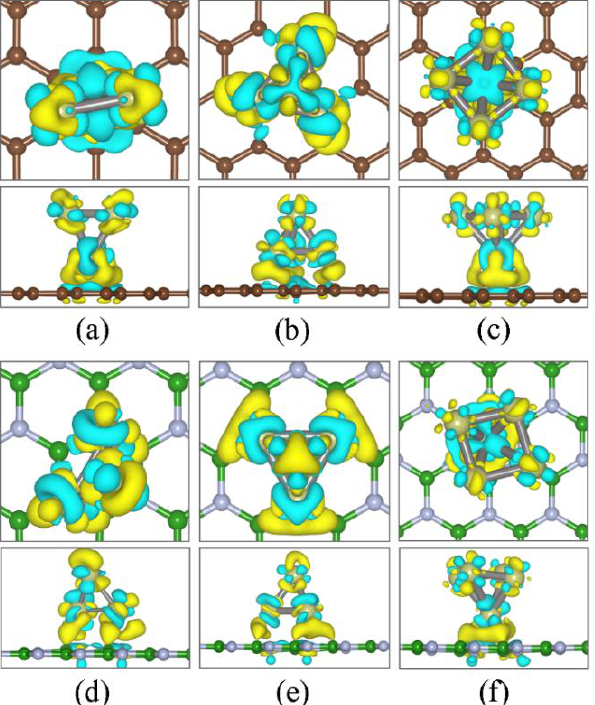
Figure 6. CDD of the most stable structure of Ir 3 to Ir 5 adsorbed on graphene ( a – c ) and h BN ( d – f ). Every figure shows the top and side views of CDD, respectively. Yellow and blue isosurfaces represent positive and negative charge densities. The isosurface is set at 0.005 e Å − 3